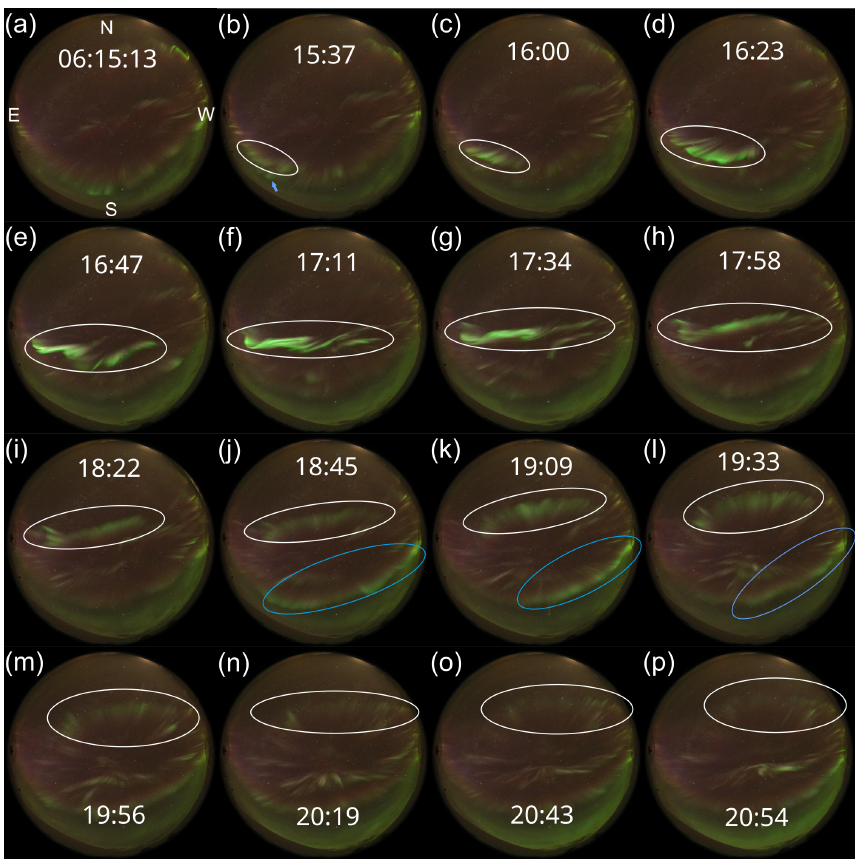
Figure 2. Typical morphological evolution of a PMAF in ASC images. A series of ASC images showing the evolution of the morphology of a PMAF (white ellipse) in event list 1. The images were taken without a narrow-band filter at the Kjell Henriksen Observatory. The orientation of the images is magnetic N–W–S–E, starting from the up direction and going clockwise (see compass rose in image a ). Image (a) was taken on 18 December 2017 at 06:15:13UTC. The appropriate time of each following image is printed in the [mm:ss]